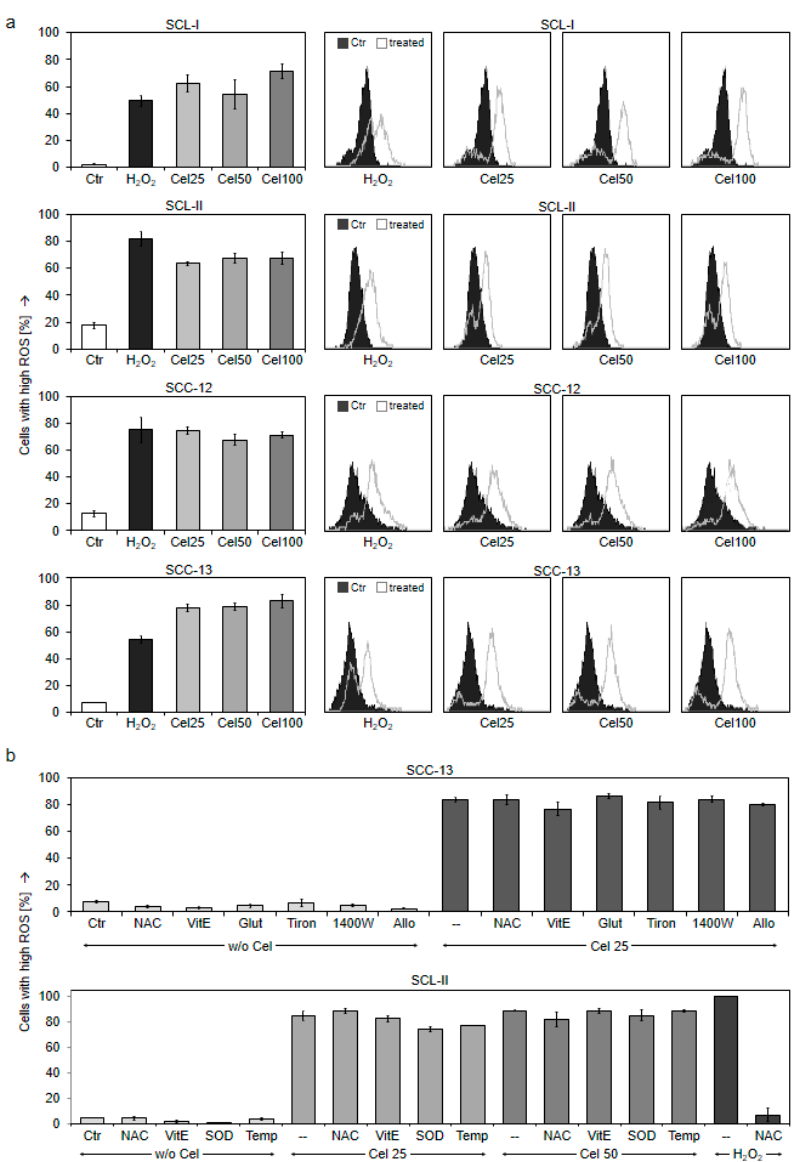
Figure 8. Strongly enhanced ROS levels by celecoxib. ( a ) Four cSCC cell lines were treated for 2 h with increasing concentrations of celecoxib (25, 50, and 100 µ M), whereas H 2 O 2 (1 mM, 1 h) was used as a positive control. ROS levels were determined by H 2 DCFDA staining and flow cytometry. Mean values +/ − SDs of representative experiments are shown; at least two independent experiments, each one consisting of triplicate values, revealed highly comparable results. Example cytometry measurements (overlays vs. controls) are shown on the right side. ( b ) Treatment with different antioxidative strategies is shown in SCC-13 and SCL-II in addition to celecoxib treatment (25 and 50 µ M): NAC, N-acetyl cysteine (1 mM); VitE, tocopherol (1 mM); Glut, glutathione (1 mM); Tiron (1 mM); 1400W (100 µ M); Allo, Allopurinol (1 mM); Temp, Tempol (1 mM). Antioxydants were generally applied at 1 h before